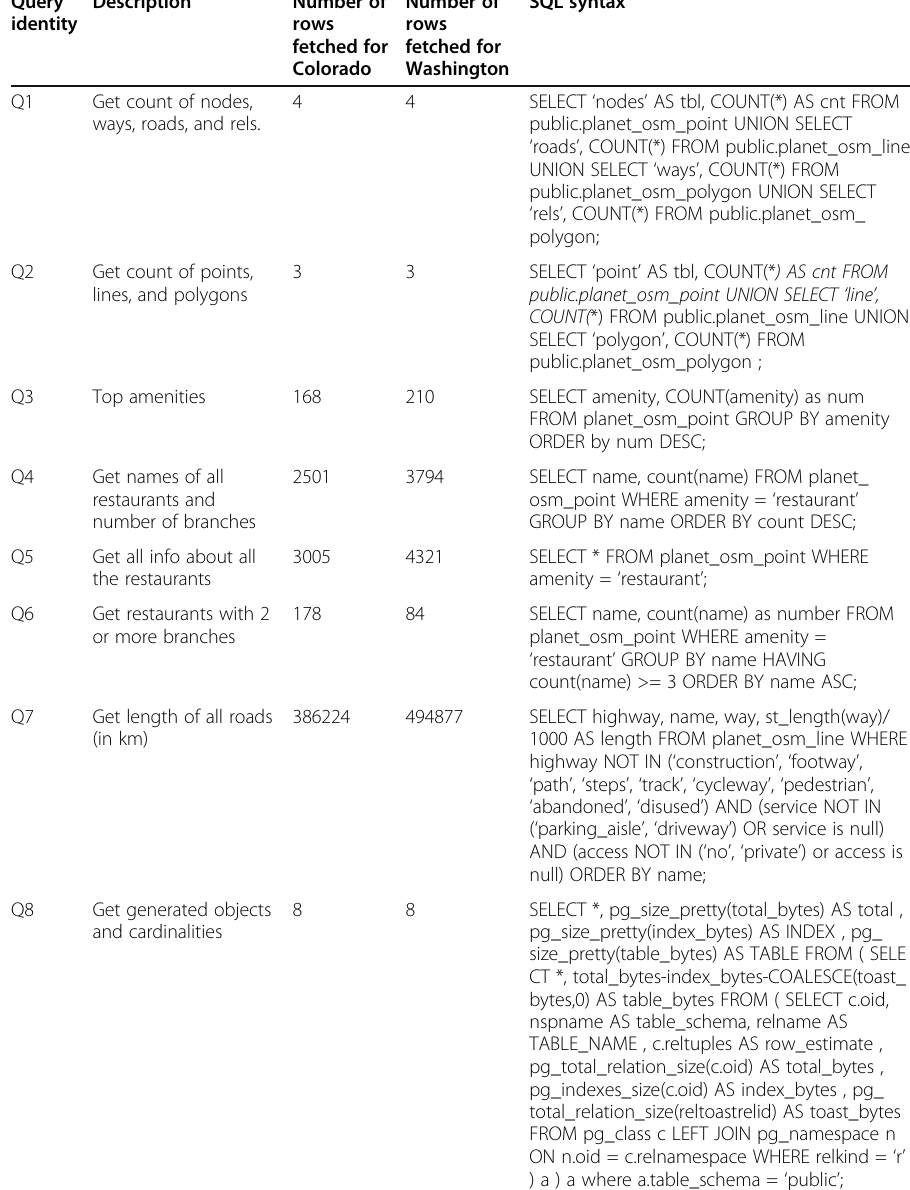
Table 3 Benchmarking queries Query Description Number of identity